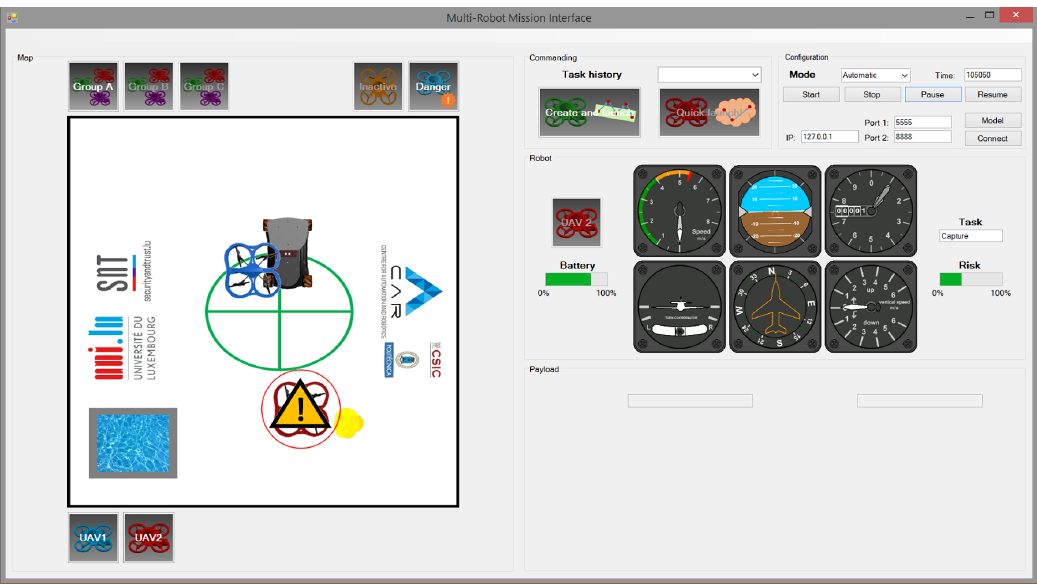
Figure 8. Conventional interface with predictive